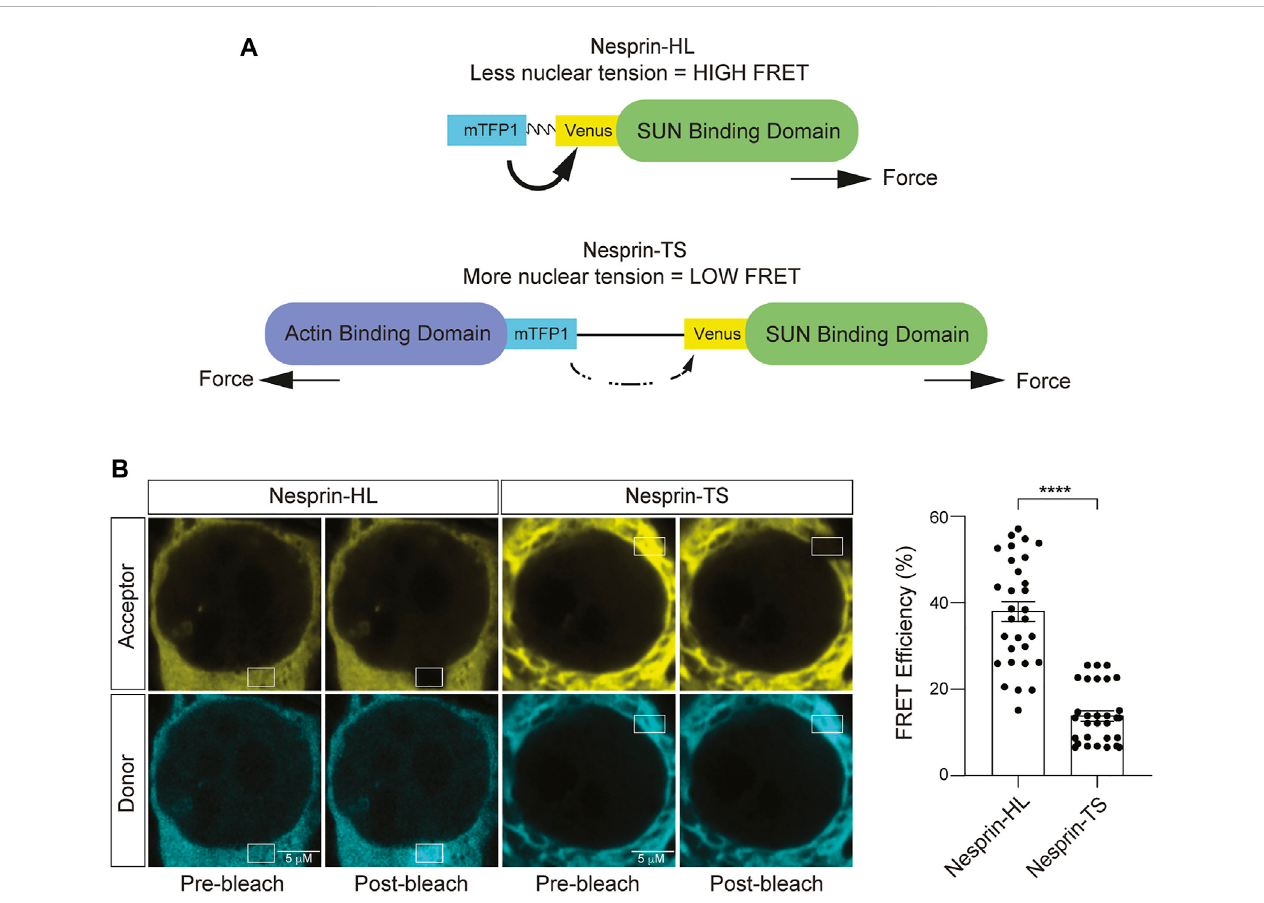
FIGURE 3 Developmentofanucleartensionsensorinneuroblastomacells. (A) Schematicofnesprin-HLandnesprin-TSandtheinverserelationshipbetweenFRET and nuclear tension. (B) Acceptor photobleach-based quanti fi cation of FRET in nesprin-HL and nesprin-TS expressing BE(2)-C cells. Each datapoint represents FRET analyzed in a single nucleus. Thirty nuclei were analyzed across three different wells (10 nuclei/well), t -test, ** p < 0.01. Error bars indicate